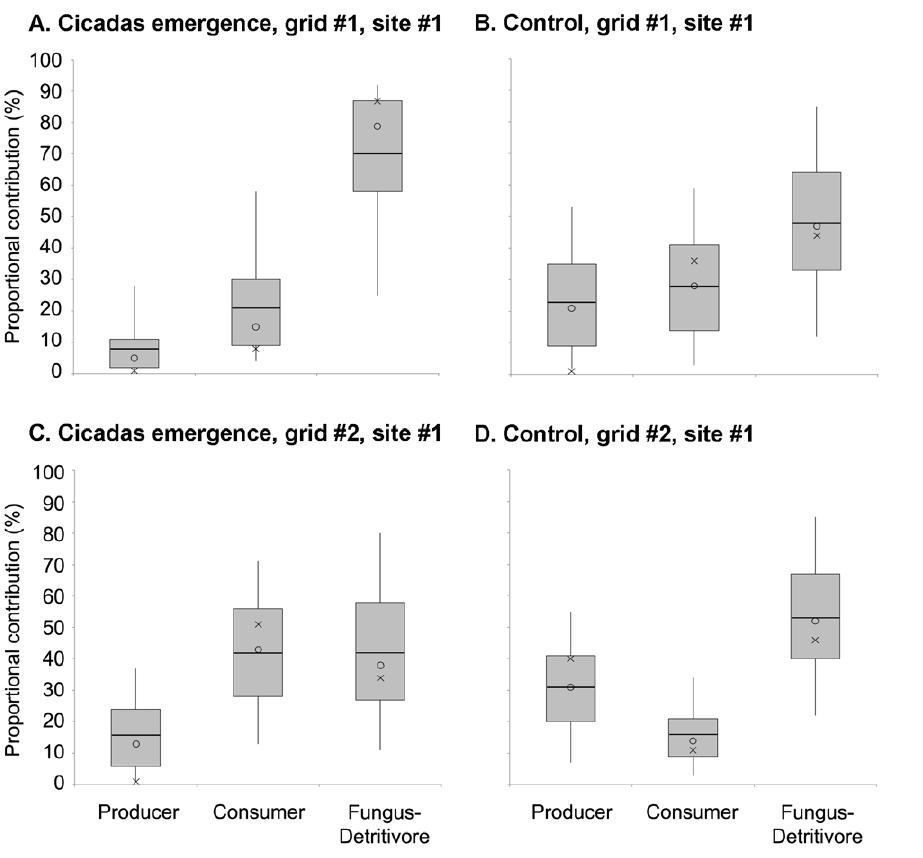
Figure 4. The producer, consumer, and fungus-detritivore contributions to the mouse diets in the cicadas emergence experiment. The cicadas emergence grids were plotted on the left and the control grids on the right for the first grid (A, B) and the second grid (C, D). The probability distributions of above-ground arthropods and the cicadas were combined to represent the consumer contributions in the cicadas emergence grids (A, C). The lines, circles, and crosses denote the means, medians, and modes. The boxes and whiskers denote the 25–75th and 5– 95th percentiles, respectively.